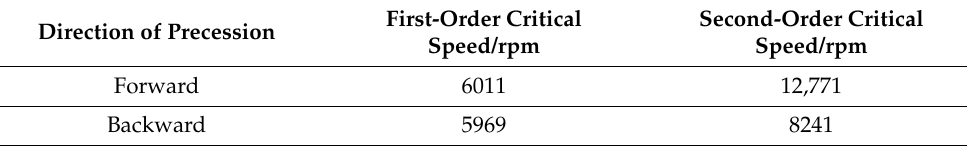
Figure 5. Campbell diagram of high-pressure rotor. According to the Campbell diagram, the intersection of the straight line with slope 1 and forward precession and backward precession is the critical speed. The critical speed of the high-pressure rotor system is shown in Table 5. Table 5. Critical speed of the high-pressure rotor